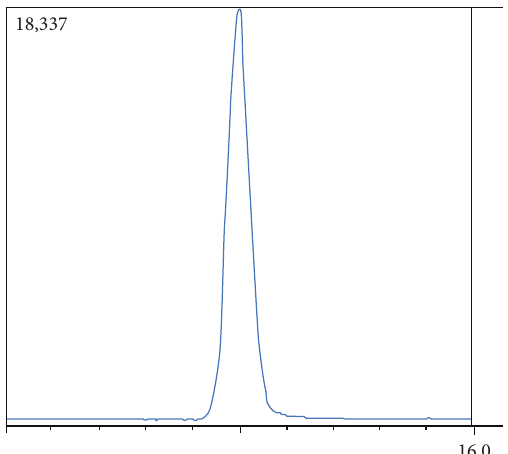
Figure 13: GC-MS chromatogram of dieldrin standard of 200ppm.